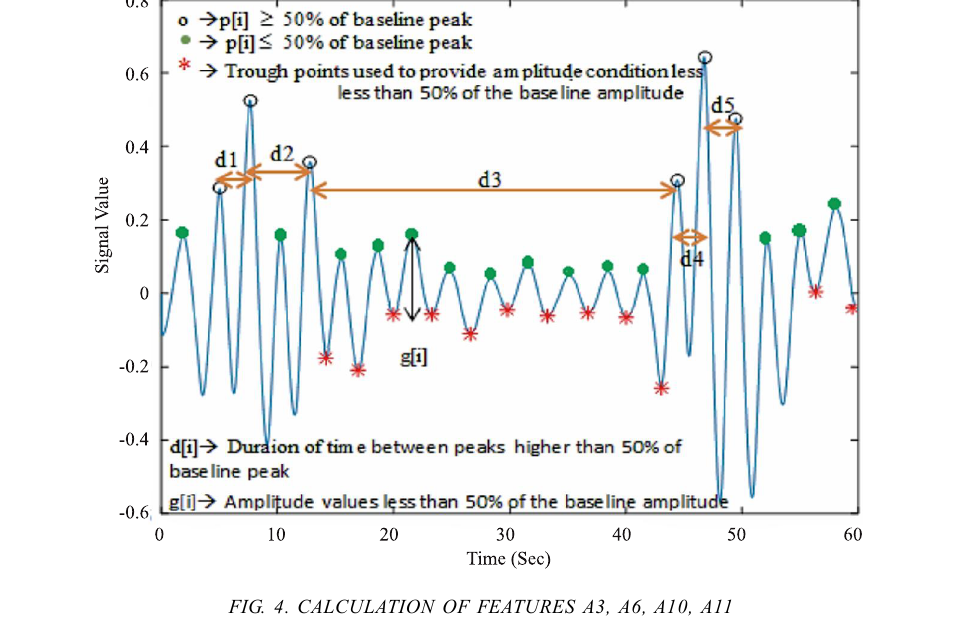
FIG. 4. CALCULATION OF FEATURES A3, A6, A10,